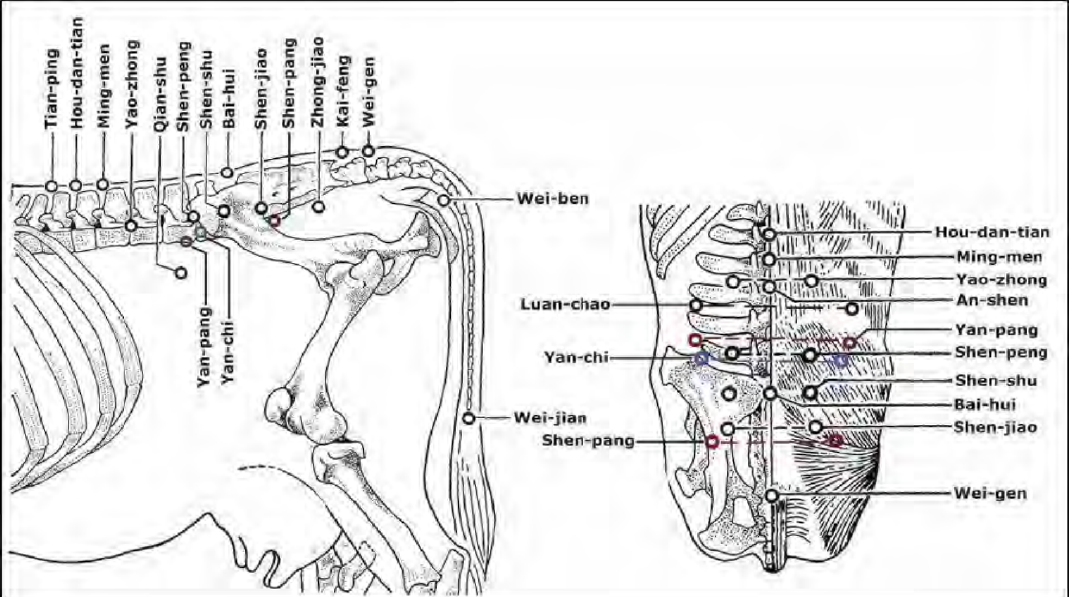
Figure 2. Location of acupoints Yan-pang, Shen-pang, Luan-chao, and Wei-ben used in this study and their relationship to other classical acupoints of cows. The new bovine acupoint Yan-pang (red circle) is located by identifying Bai-hui at the lumbosacral space on the midline and moving cranioventrally to the muscular depression at a line parallel to the cranial edge of the transverse processes of the 5th lumbar vertebra (left and right pictures). The other new bovine acupoint Shen-pang (red circle) is located by identifying Bai-hui at the lumbosacral space on the midline and moving caudoventrally, along the popliteal groove of the gluteus medius to the depression at the intersection of the grooves of the gluteus medius and the biceps flexor cruris (left and right pictures). The classical acupoint Luan-chao is located at the craniolateral edge of the transverse process of the 4th lumbar vertebra in line with Yan-pang (right picture). The classical acupoint Wei-ben is located on the ventral side of the tail between the 5th and 6th caudal vertebrae (left picture). (Used with